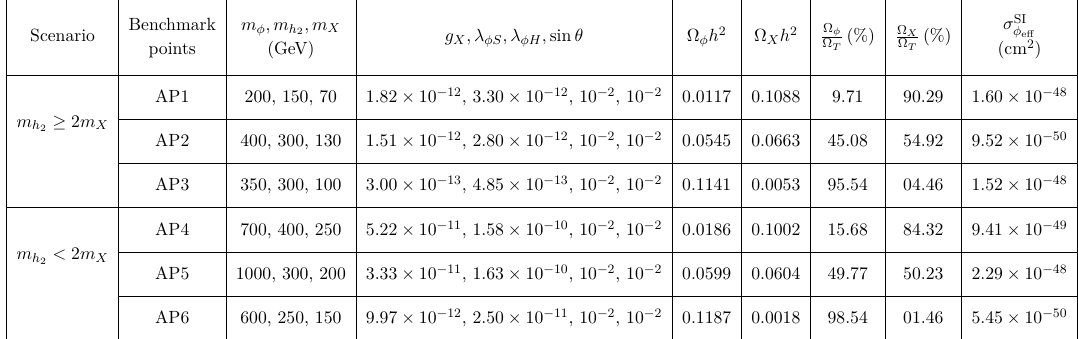
Table 5 . Some sample benchmark points for the WIMP-FIMP DM model, when both freeze-in and freeze-out occur aEWSB respecting the total relic density, direct search, Higgs mass/mixing and other constraints. The benchmark points depict the possibilities when one component dominates over the other as well as the cases when they have almost equal share for the relic